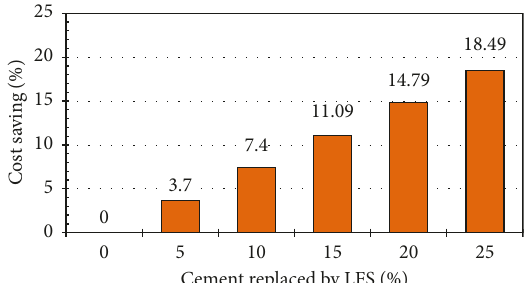
Figure 14: Probable economic benefit of partial cement replace- ment by LFS.